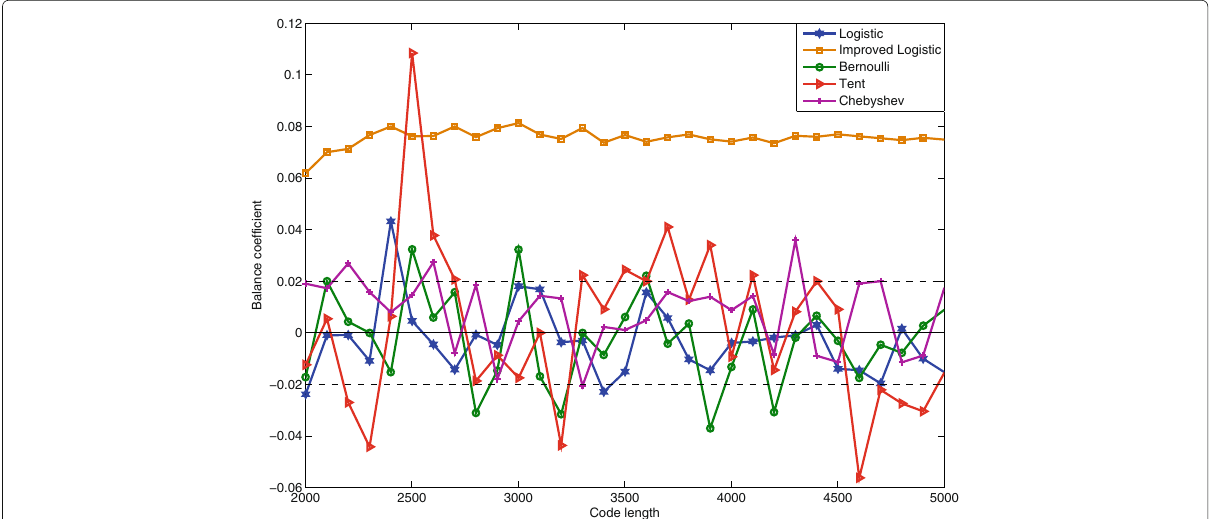
Fig. 1 Relation curves between balance coefficients of classical chaotic sequences and various code